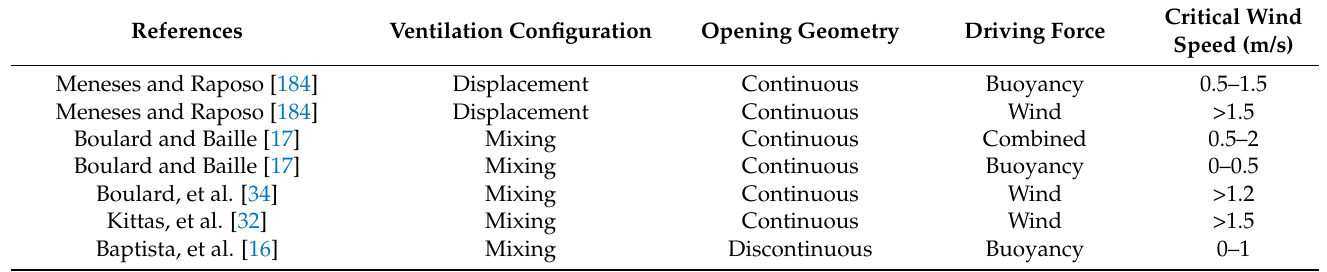
Table 2. The critical wind speed defining the dominant drivers of natural